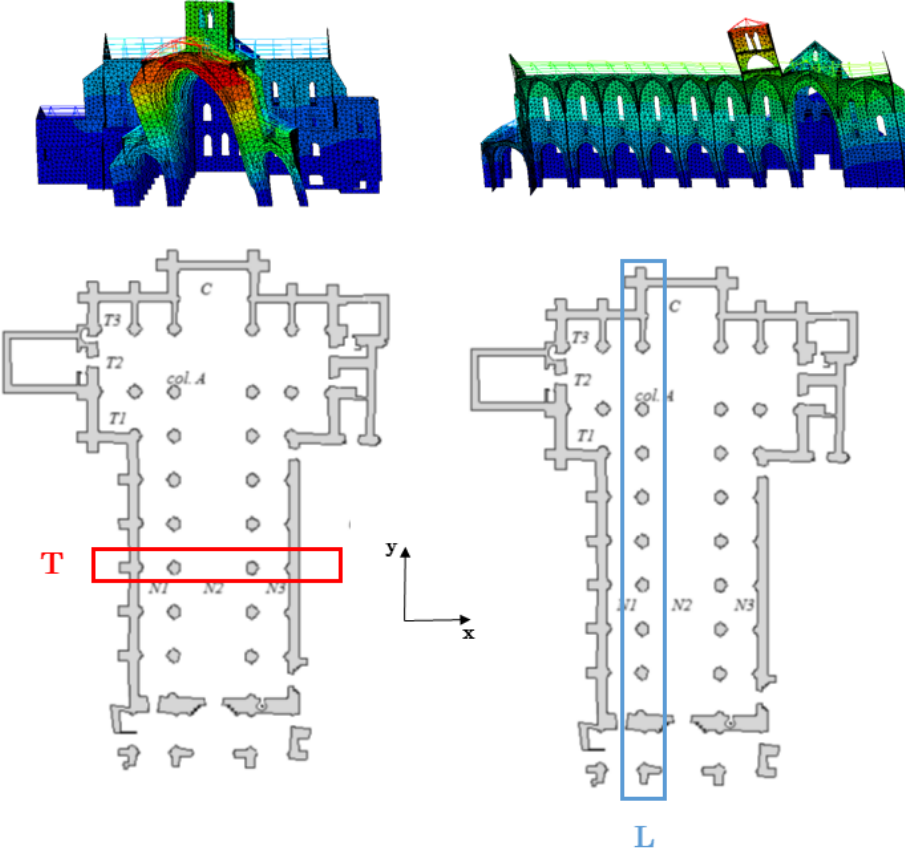
Figure 9. Selected two-dimensional